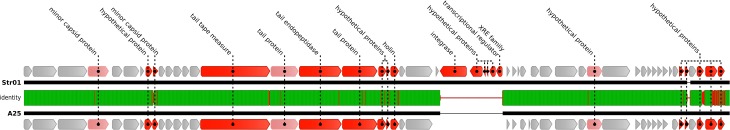
Similarities between genomes of Str01 and A25.Genome map of both phages are shown in a pairwise alignment. Arrows indicate genes and are colored according to the gene similarity (grey–identical genes, pink–genes with silent mutations, red–genes with amino acid substitutions in protein products). The middle bar shows DNA sequence similarity between the two genomes. Regions with no alignment are shown as a thin black line.